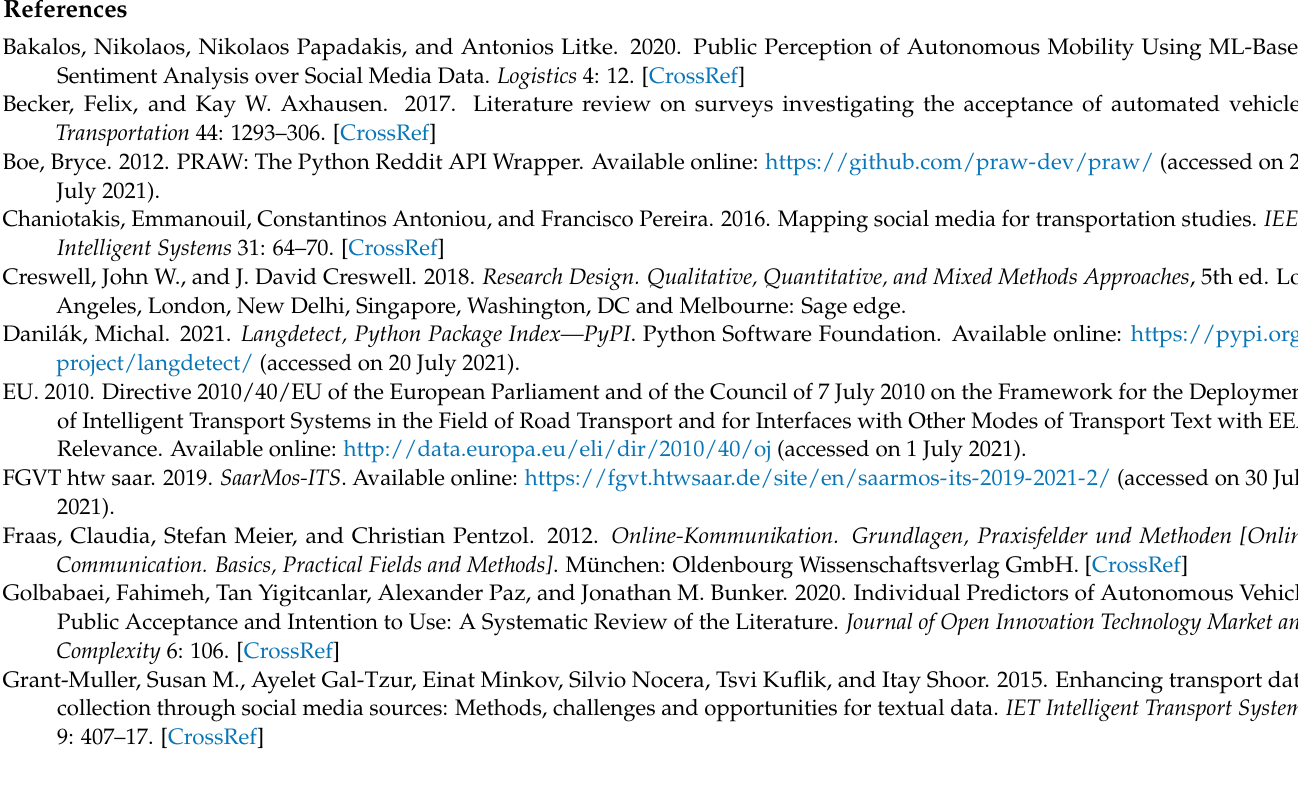
conditions, procedure) have already been performed and explained at the beginning of this